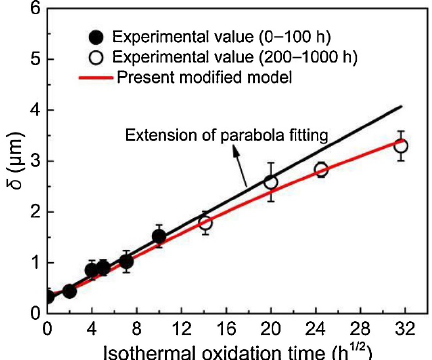
Fig. 36 Comparison between conventional parabolic kinetics and Zhang’s non-parabolic kinetics. Reproduced with permission from Ref. [194], © Elsevier B.V. 2017.